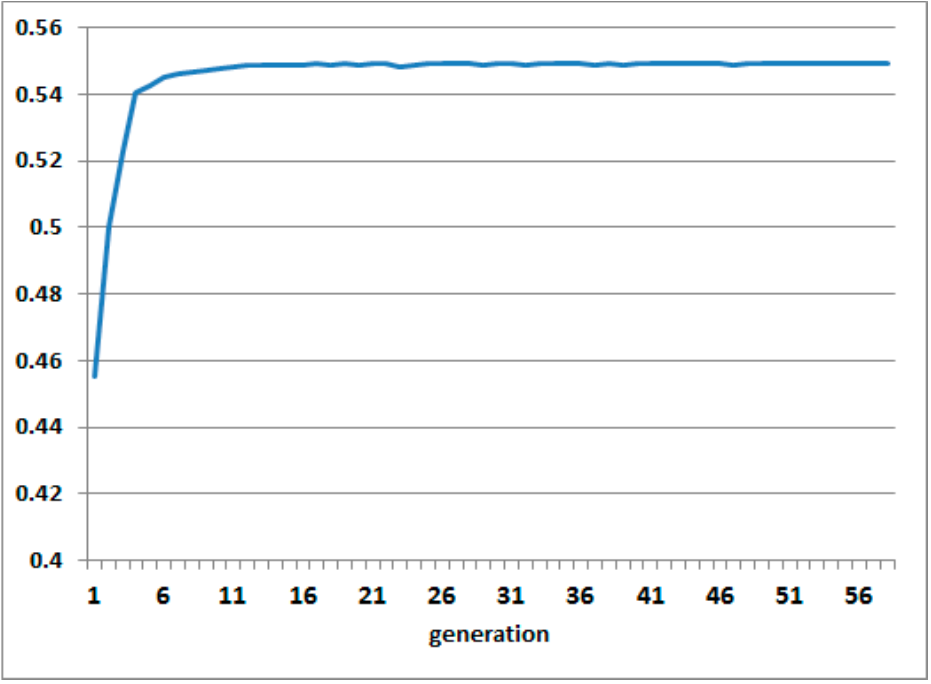
Figure 12. Fitness curve of proposed algorithm in binary decoding.